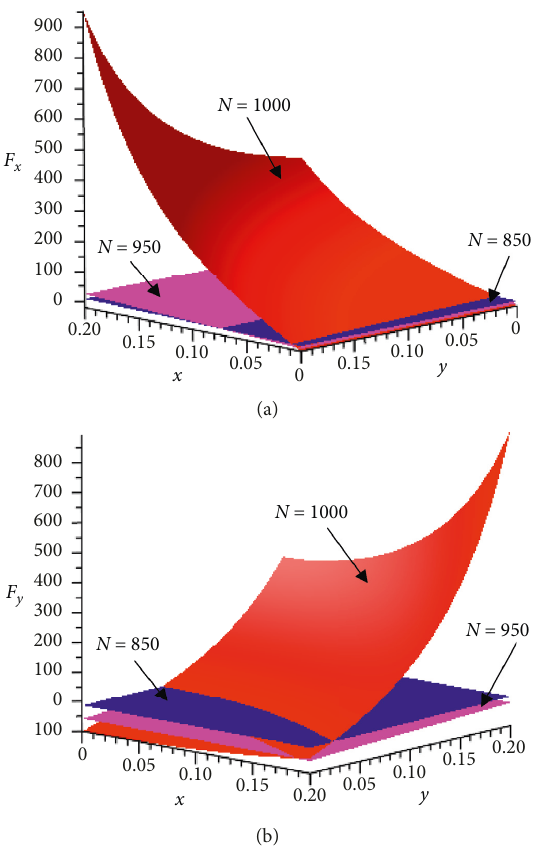
Figure 2: Electromagnetic force resultants of the rotor-AMB system with 16-pole legs obtained under different values of N : (a) electromagnetic force resultants F x in the x direction; (b) elec- tromagnetic force resultants F y in the y